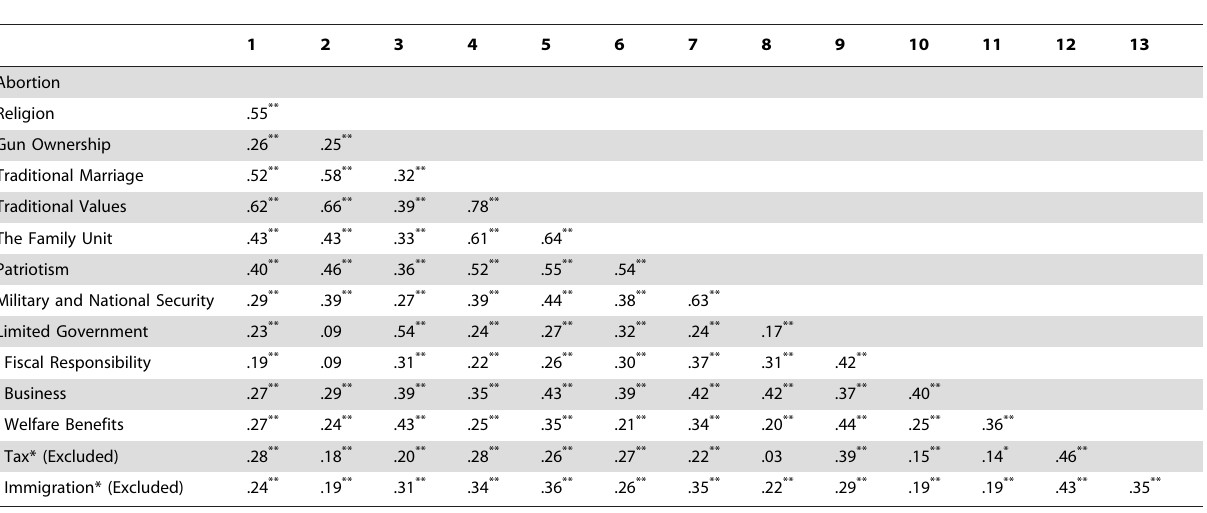
Table 1. Correlation Matrix for SECS Items.